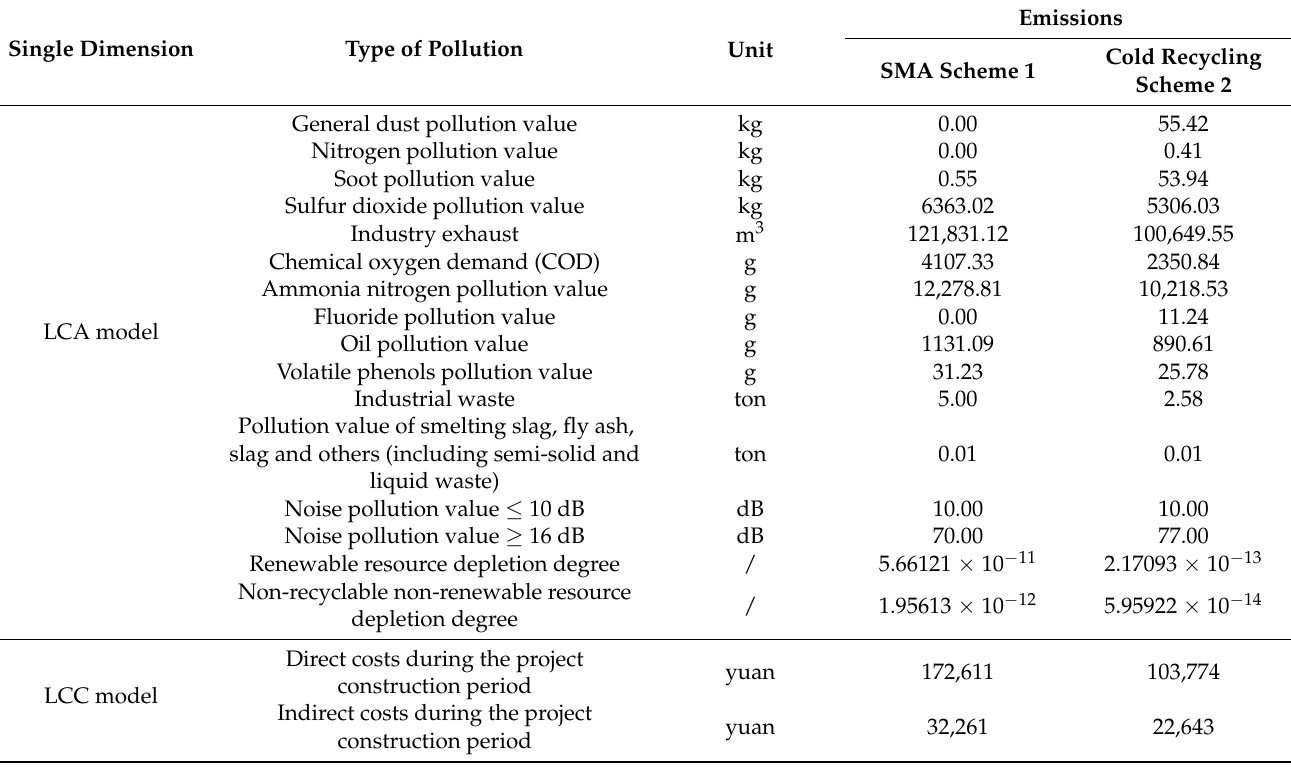
Table 2. SMA scheme and cold recycling scheme data.